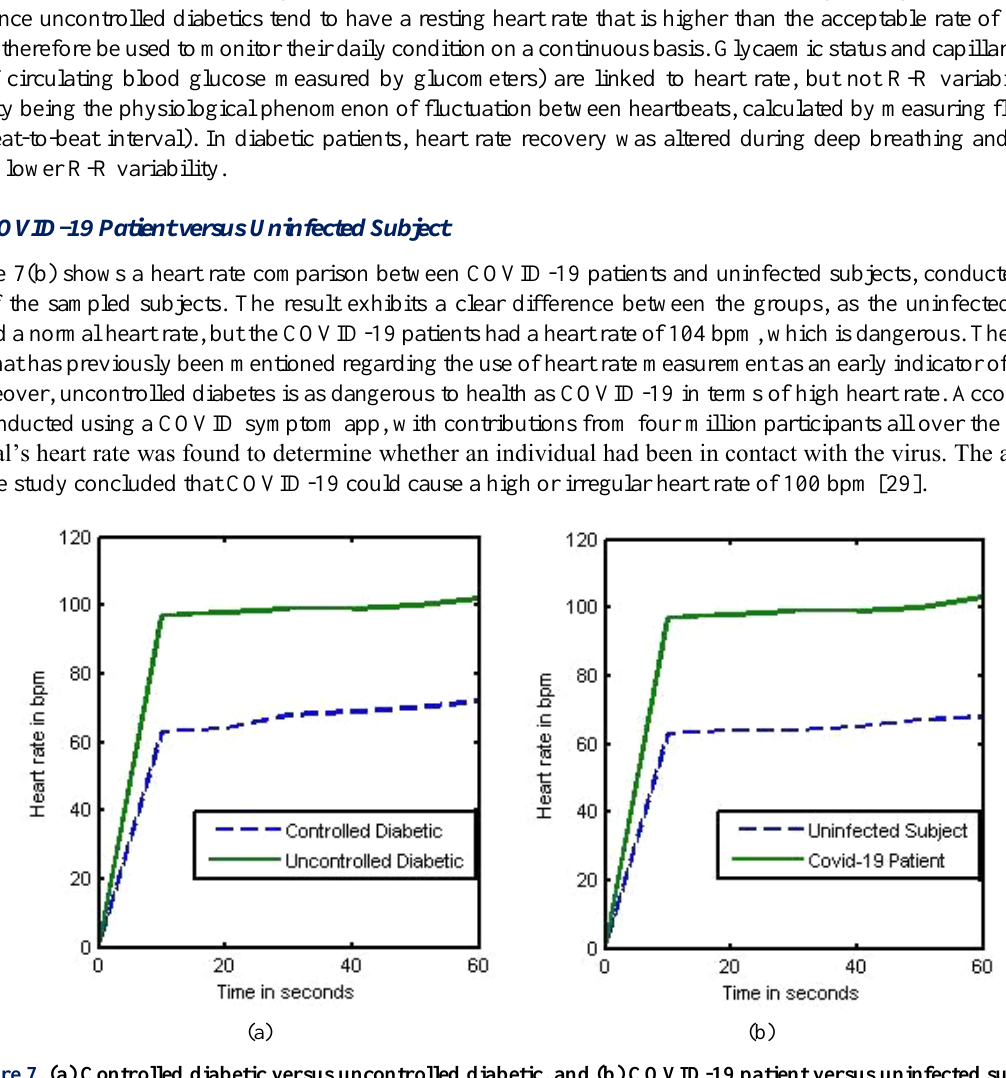
Figure 7. (a) Controlled diabetic versus uncontrolled diabetic, and (b) COVID-19 patient versus uninfected